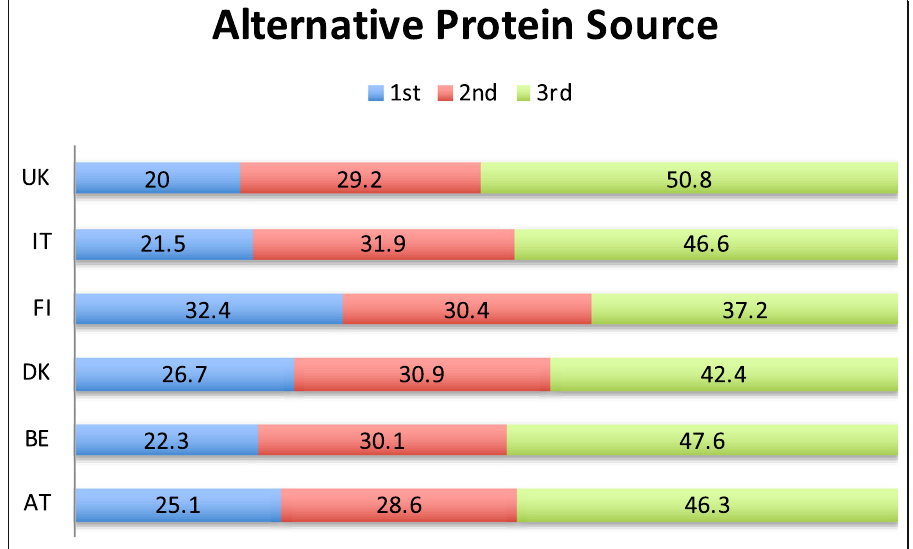
Fig. 5 Ranking of ‘ alternative protein source ’ by country (%)